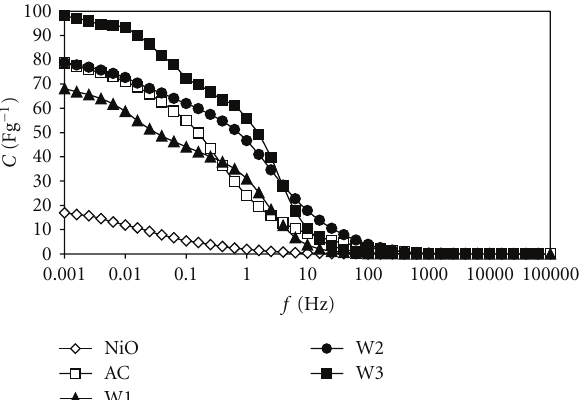
Figure 8: Capacitance versus frequency for supercapacitors built from NiO, AC, and composites NiO/AC.